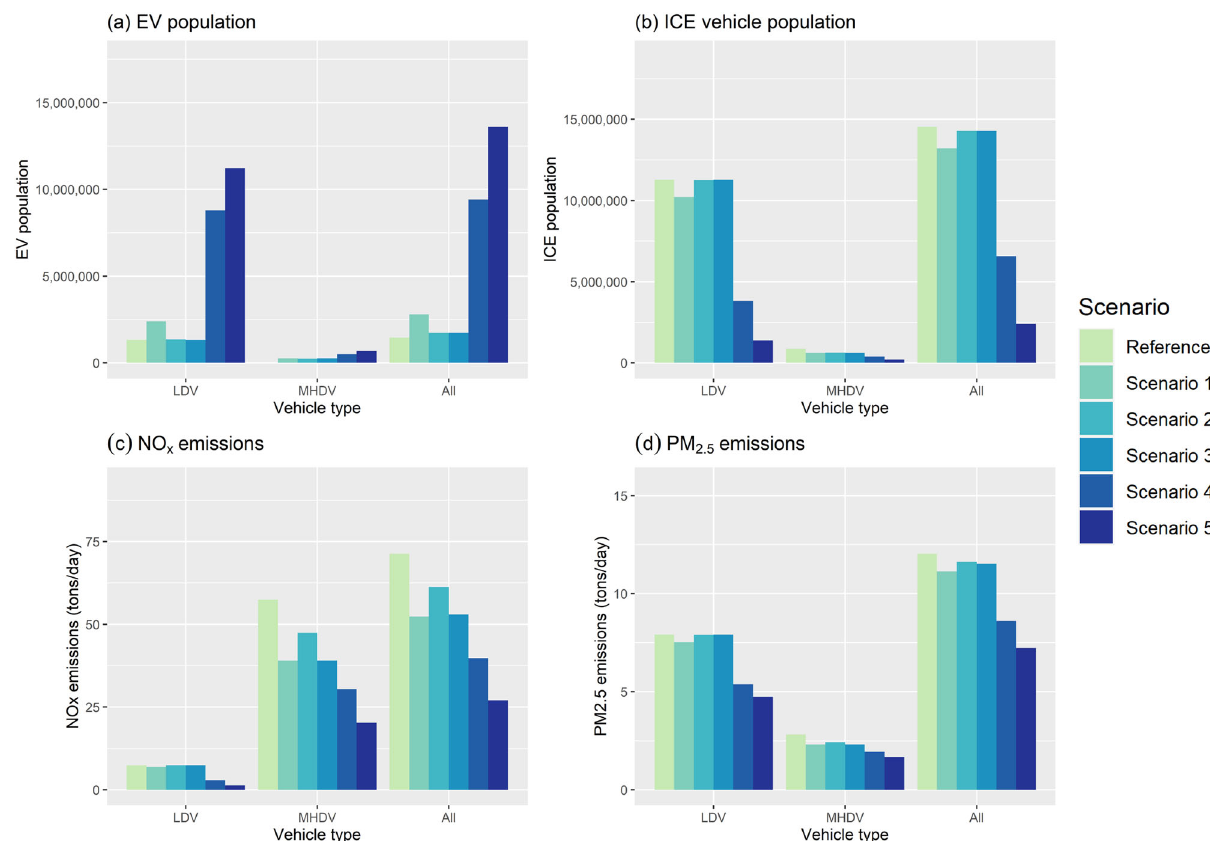
Fig. 2 Estimated vehicle population and emissions for each scenario in the South Coast region in 2040. a Electric vehicle (EV) population, b internal combustion engine (ICE) vehicle population, c NO x emissions, and d PM 2.5 emissions. PM 2.5 emissions shown here represent the combination of exhaust, tire wear, and brake wear; road dust is not included. LDV light duty vehicles, MHDV medium- and heavy-duty vehicles. All = LDV + MHDV + all remaining vehicles (such as motor homes and motorcycles) not covered by policies to accelerate EV penetration among LDV and MHDV vehicles in Scenarios 1 – 4.